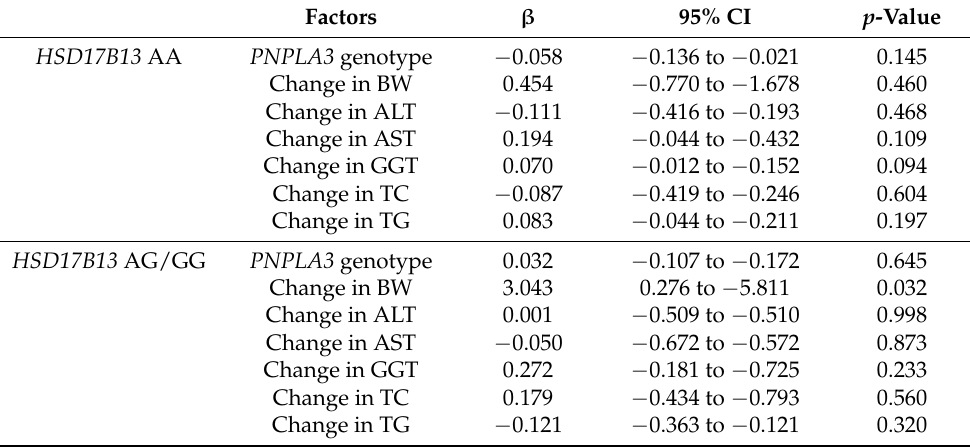
Table 4. Factors associated with change in live stiffness measurement according to the HSD17B13 genotype.